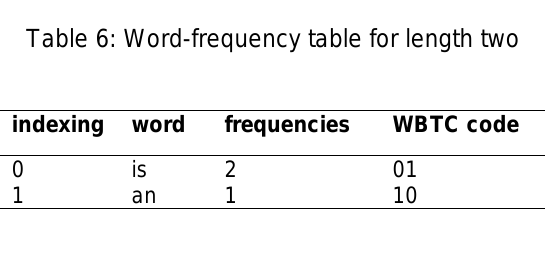
Table 13: Wt for Table 7